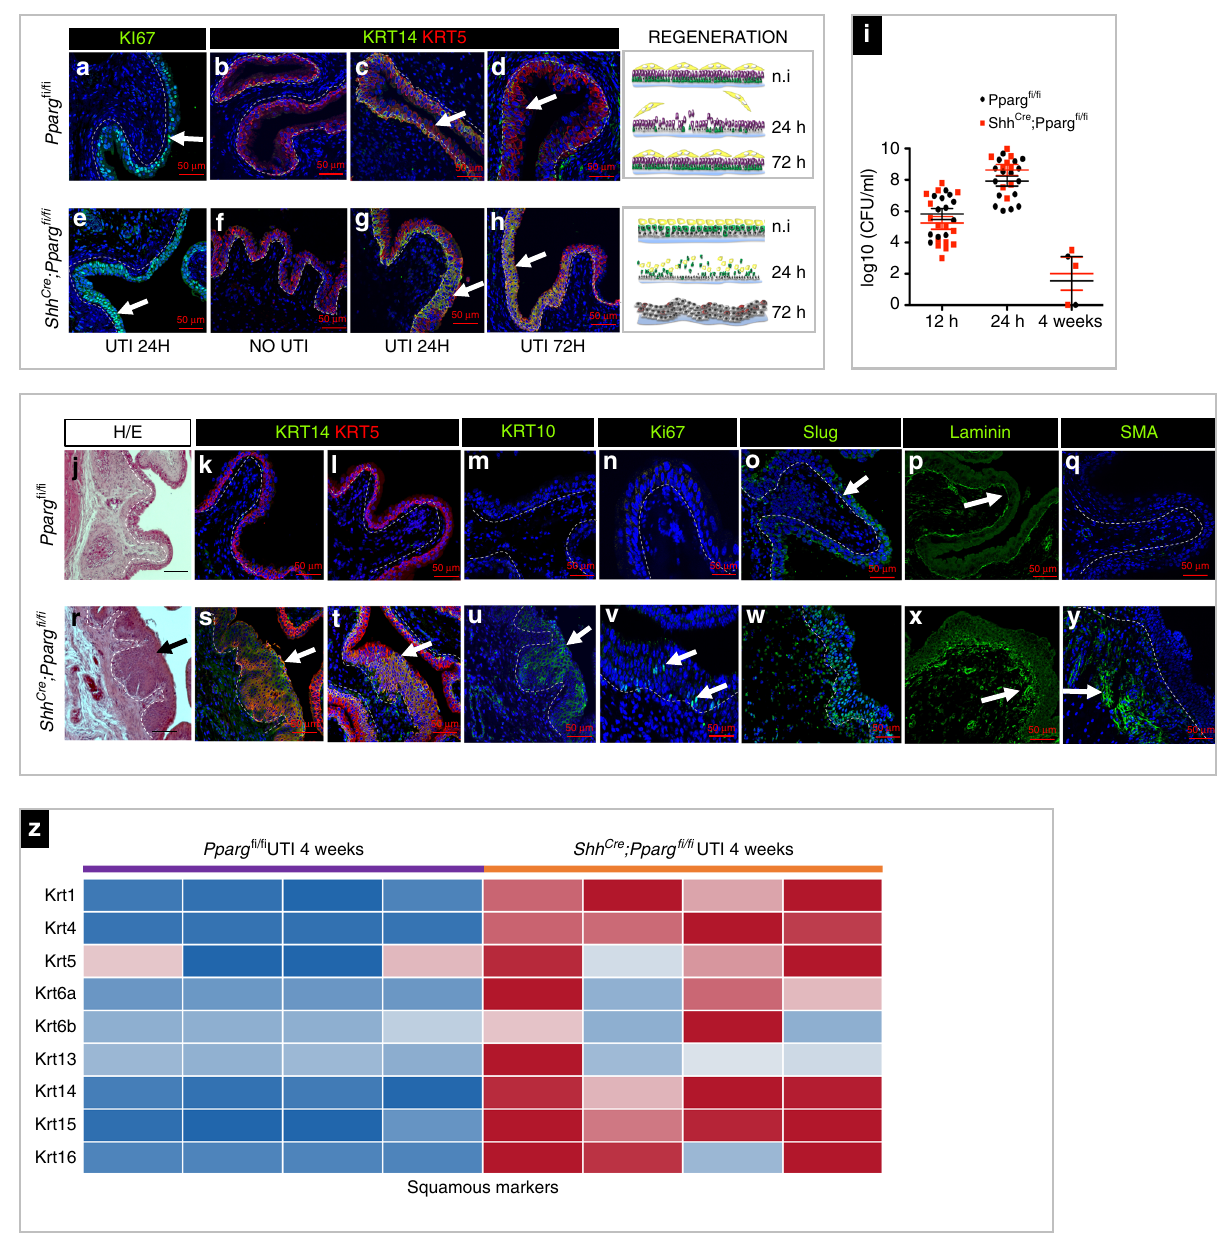
Fig. 9 UTI-induced injury leads to squamous-like differentiation and persistent in fl ammation in Pparg mutants. Expression of Ki67 in the urothelium of a Pparg fl / fl control ( a ) and in a Shh Cre ;Pparg fl / fl mutant ( e ) 24 h after UTI. Expression of Krt14 and Krt5 in adult Pparg fl / fl control mice and in Shh Cre ;Pparg fl / fl mutant mice. 0 h ( b , f ) 24 h ( c , g ), and 72 h ( d , h ) post infection. Right panels show a schematic representation of UTI-induced regeneration in the urothelium of controls (top) and Shh Cre ;Pparg fl / fl mutants (bottom). ( i ) Bacterial outgrowth (CFU) in the bladder of Pparg fl / fl control mice or Shh Cre ;Pparg fl / fl mutant mice at 12 h, 24 h, and 4 weeks post infection. j – y Analysis of Pparg fl / fl control and Shh Cre ;Pparg fl / fl mutants 4 weeks post-UTI. Hematoxylin and eosin staining of a urothelium from an adult control Pparg fl / fl mouse ( j ) and a Shh Cre ;Pparg fl / fl mutant mouse ( r ). Expression of Krt14 and Krt15 in the urothelium of an adult control Pparg fl / fl mouse ( k , l ) and a Shh Cre ;Pparg fl / fl mutant mouse ( s , t ). Expression of Krt10 in the urothelium of an adult control Pparg fl / fl mouse ( m ) and a Shh Cre ;Pparg fl / fl mutant mouse ( u ). Expression of Ki67 in the urothelium of an adult control Pparg fl / fl mouse ( n ) and a Shh Cre ; Pparg fl / fl mutant mouse ( v ). Expression of Slug in the urothelium of an adult control Pparg fl / fl mouse ( o ) and a Shh Cre ;Pparg fl / fl mutant mouse ( w ). Expression of laminin in the of a urothelium of an adult control Pparg fl / fl mouse ( p ) and a Shh Cre ;Pparg fl / fl mutant mouse ( x ). Expression of SMA in the urothelium of an adult control Pparg fl / fl mouse ( q ) and a Shh Cre ;Pparg fl / fl mutant mouse ( y ). ( z ) A heatmap based on RNA-Seq analysis of Shh Cre ;Pparg fl / fl mutants vs. control mice 4 weeks after UTI showing expression of squamous markers. Scale bars: 50 μ m. The number of mutants and controls was analyzed: UTI 24 h Pparg fl / fl , n = 3; Shh Cre ;Ppargf l/ fl , n = 3; UTI 72 h Pparg fl / fl , n = 4; Shh Cre ;Pparg fl / fl , n = 4; UTI 4 weeks Pparg fl / fl , n = 8; Shh Cre ;Pparg fl / fl , n = 11; RNA-Seq UTI 4 weeks Pparg fl / fl , n = 5; Shh Cre ;Pparg fl / fl , n = 5. Source data are provided as a Source Data fi le